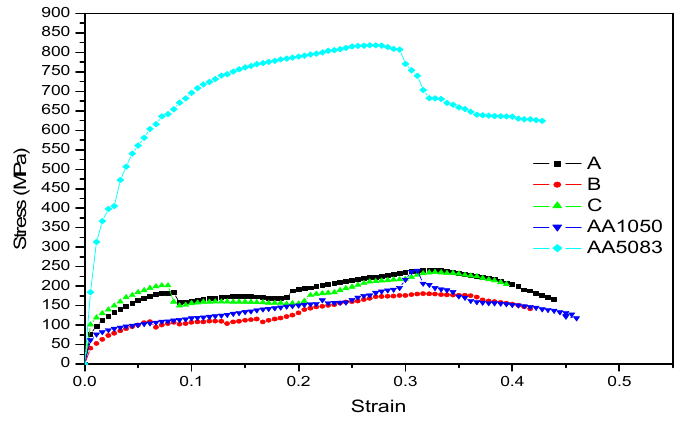
Figure 14. Bending stress—strain curves